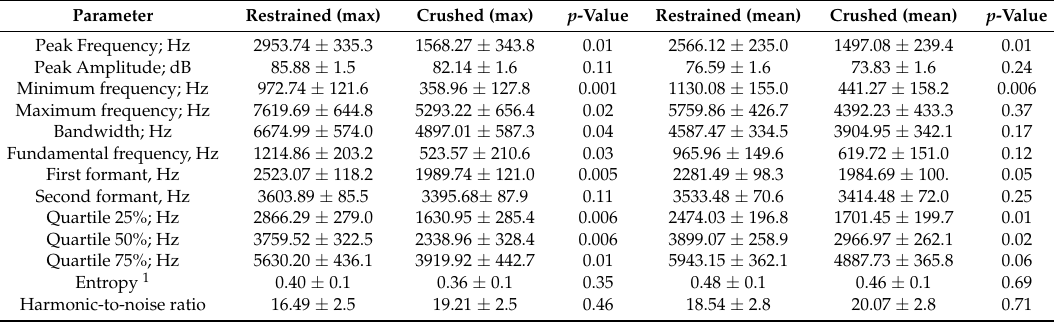
Table 2. Sound parameters measured on piglet calls collected during manual restraint by a human ( n = 10; 659 calls total) or during crushing by a sow ( n = 10; 631 calls total) during the first 48 h of